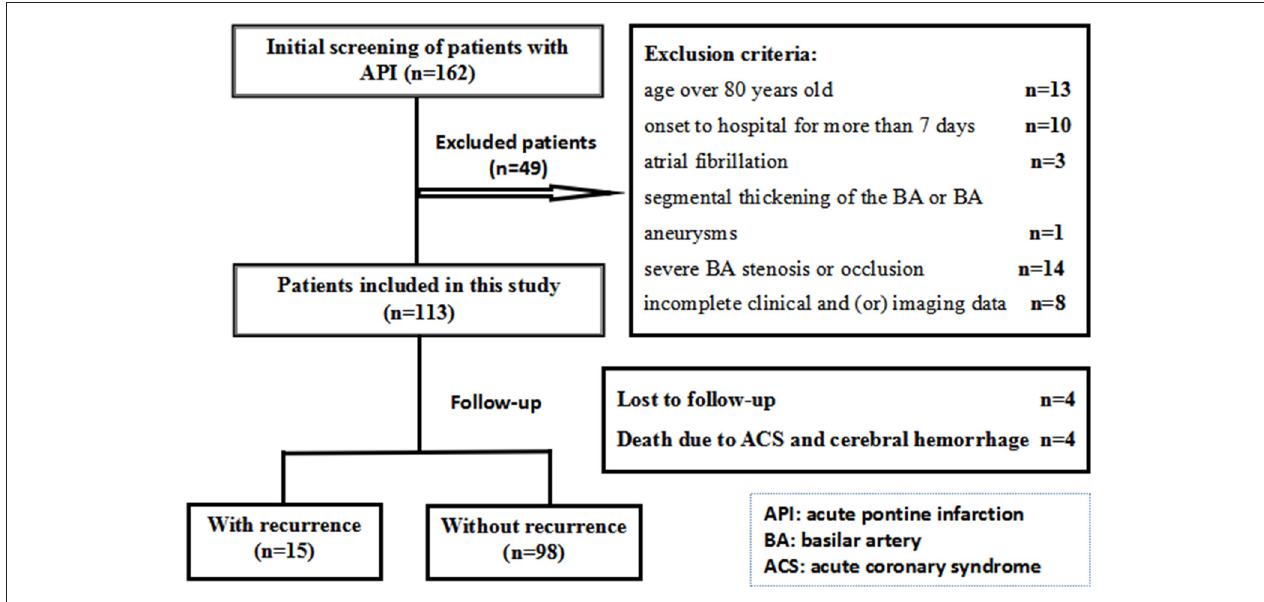
FIGURE 1 | Study flowchart of the present